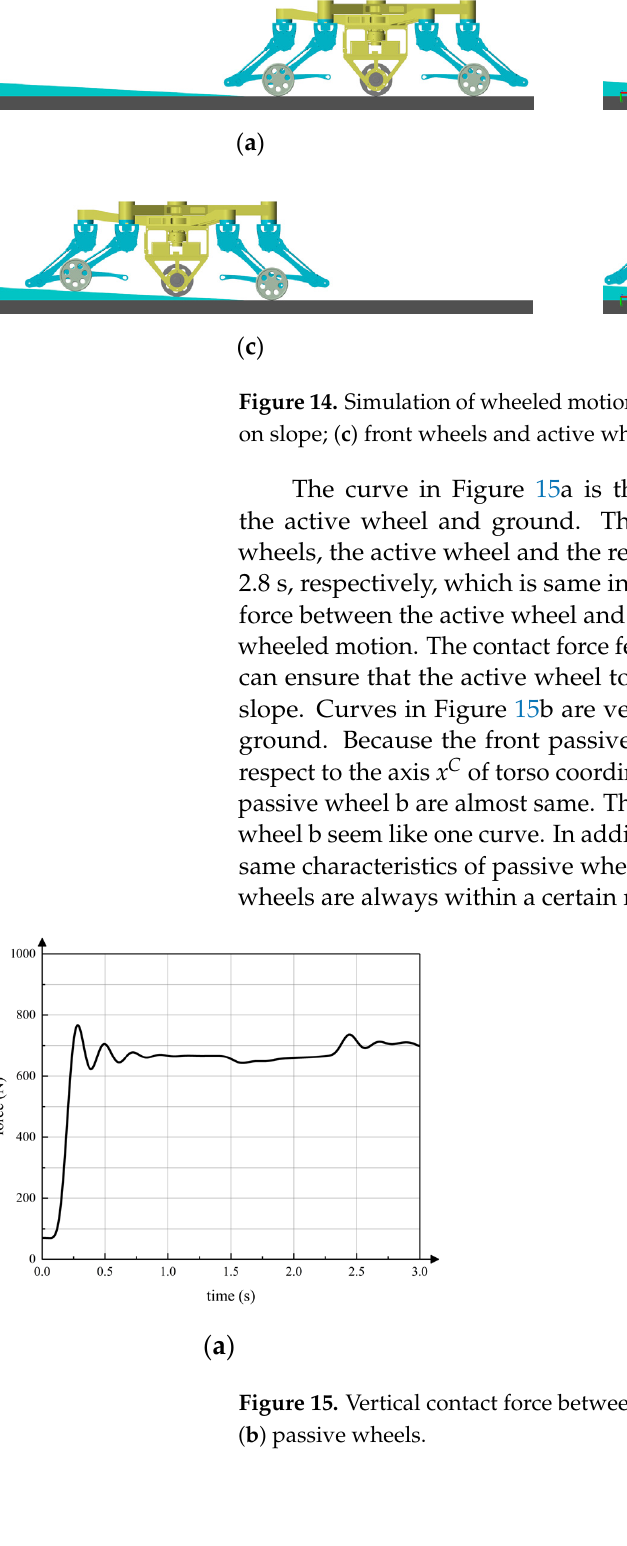
( b ) Figure 13. Posture of torso during switching motion ( a ) TeCVP; ( b ) VMC. As legs which are axisymmetric about the axis x C of torso coordinate system C are in the same state, the roll angle of the torso remains zero approximately using both control methods. Although the pitch angle changes, the magnitude is smaller than 0.005 rad in simulation. Hence, the motion planning of the leg-to-wheel switching process and the wheel-to-leg switching process in Section 3 can realize smooth conversion from the legged configuration to wheeled configuration. 5.3. Wheeled Motion